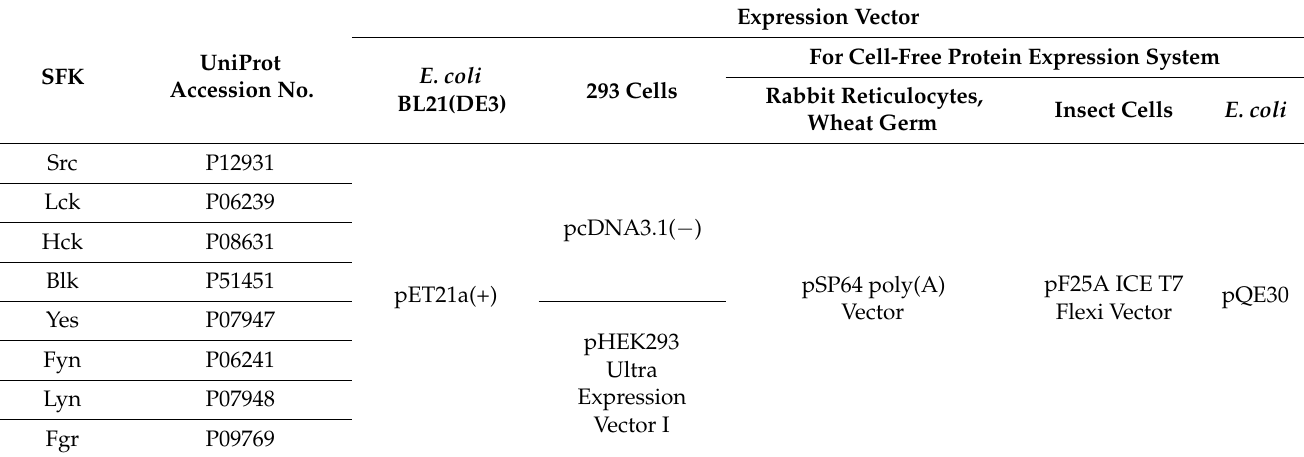
Figure 1. The plasmids constructed in this study. Table 1. The Uniprot Accession No. of each SFK and expression vector for subcloning.